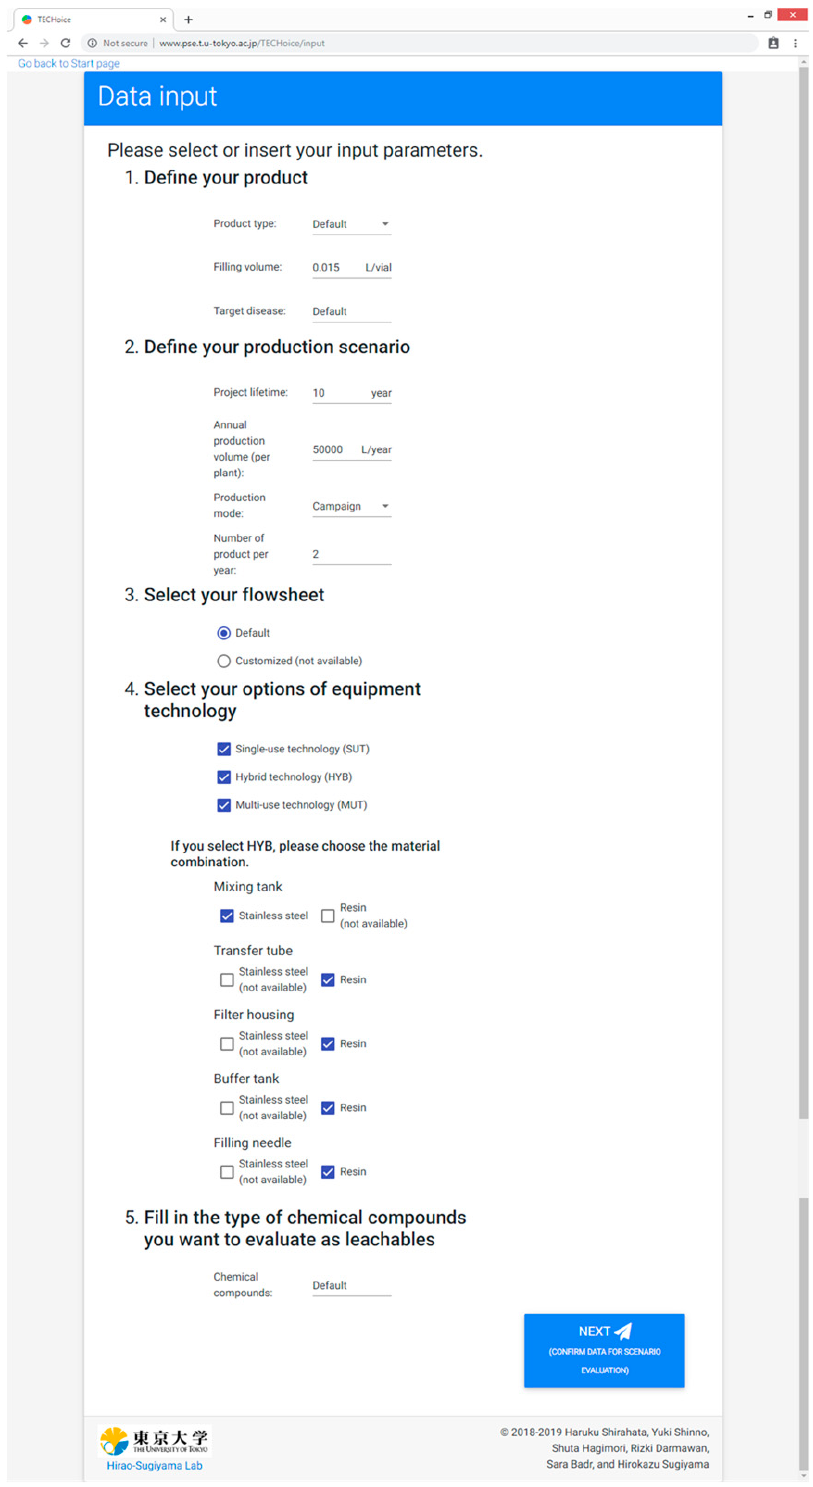
Figure A2. Screenshot of the second page (Data input) of “ TECH oice”.